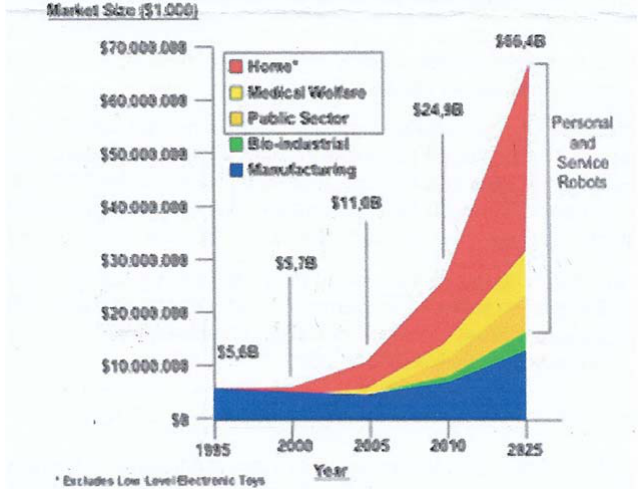
Figure 1. Projection of the evolution of the robotics market (source: Japan Robotics